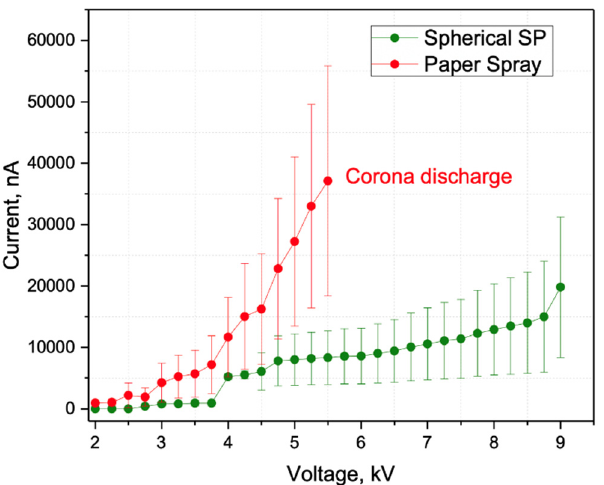
Figure 3. Electrospray current as a function of applied voltage in the range 2–9 kV (negative ion mode). Solvent—1:1 ( v / v ) MeOH:i-PrOH. The distance between the tip of the ion source and the counter electrode is 10.0 mm, angle 30°.